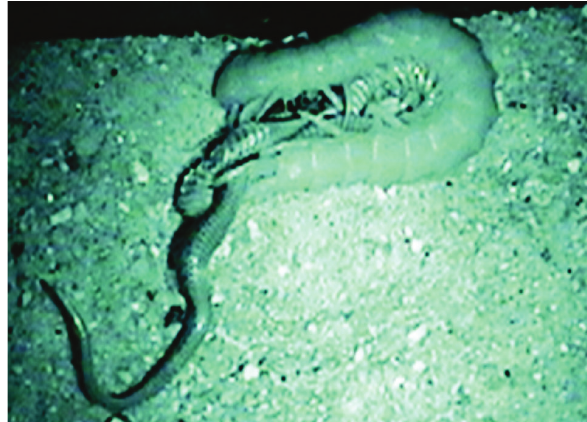
Figure 5. Image captured by video camera during predation by centi- pedes during experiments conducted to map and describe predatory behavior of three centipede species of the order